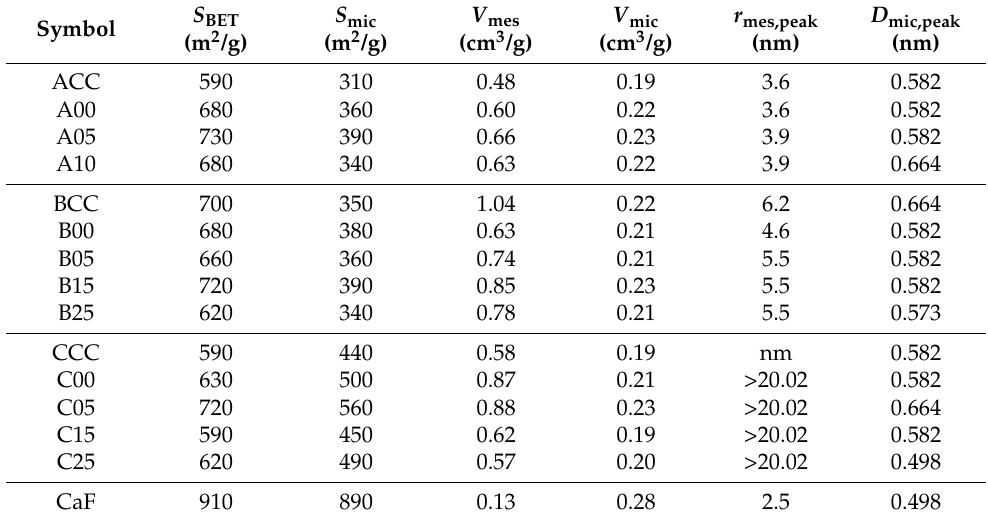
Table 2. Porous properties of CaF and C/C composite xerogels prepared under various synthesis conditions.